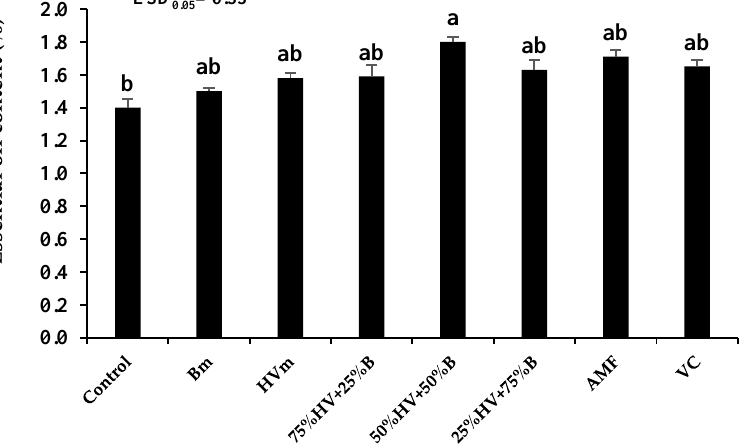
Figure 3. The essential oil content of peppermint in different fertilizer sources. Bm (Barley monoculture); HVm (hairy vetch monoculture); 50%HV + 50%B, 75%HV + 25%B and 25%HV + 75%B (different intercrop ratios of hairy vetch/barley); AMF (arbuscular mycorrhizal fungi); VC (vermicompost). Same letters above the bars do not differ significantly ( p < 0.05) according to LSD test.